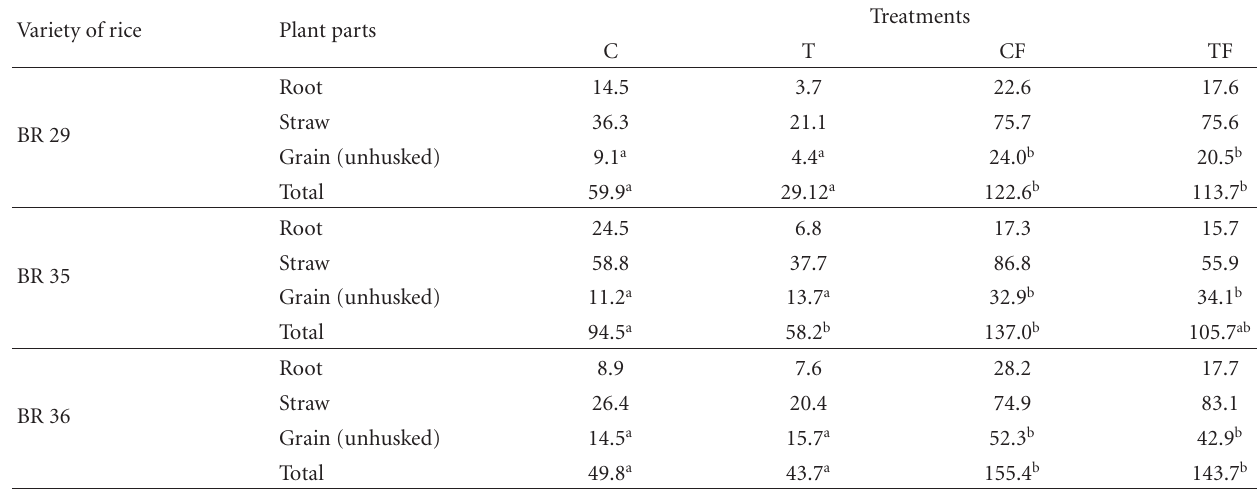
Table 3: Yield (g) of the boro rice plants.